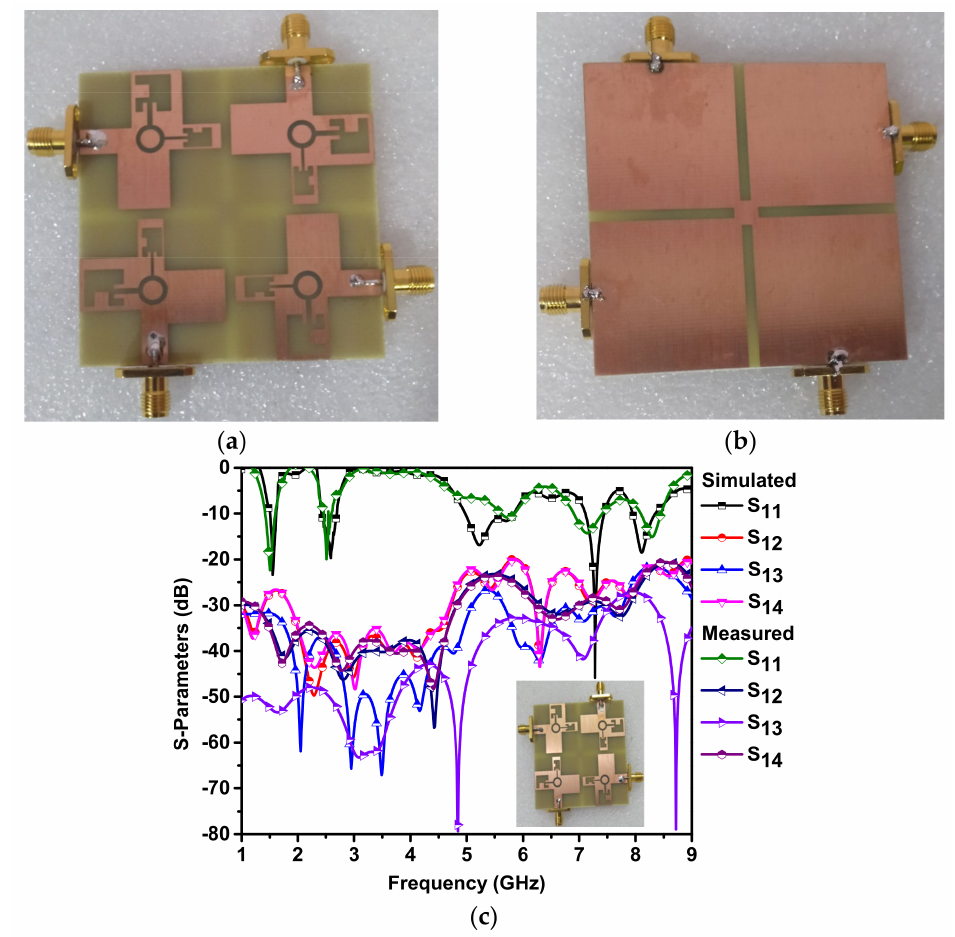
Figure 10. Fabricated prototype and S-parameter validation comparison. ( a ) Top, ( b ) bottom, and ( c ) simulated and measured S-parameter